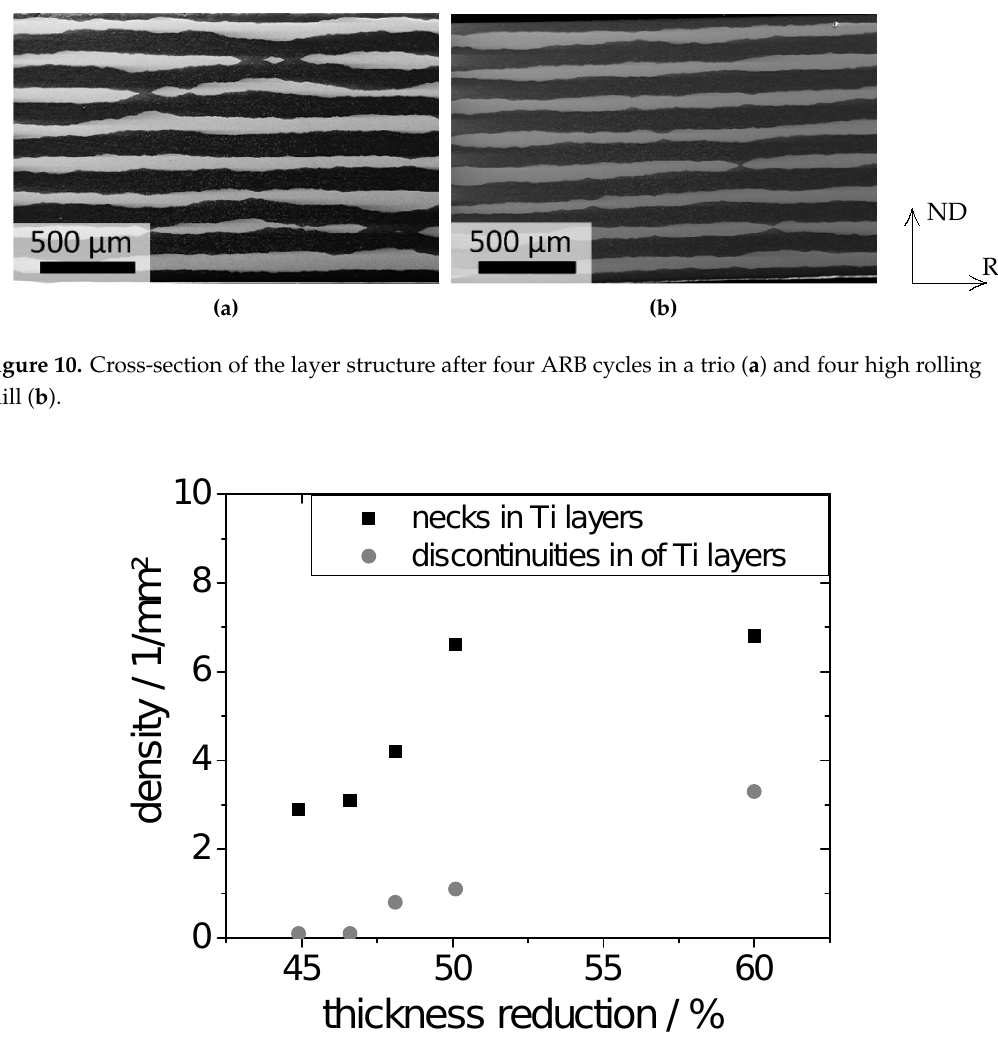
Figure 11. Density of necks and separated necks of a Ti/Al composite sheet after four ARB passes in a trio rolling mill in dependence of the thickness reduction during the last rolling